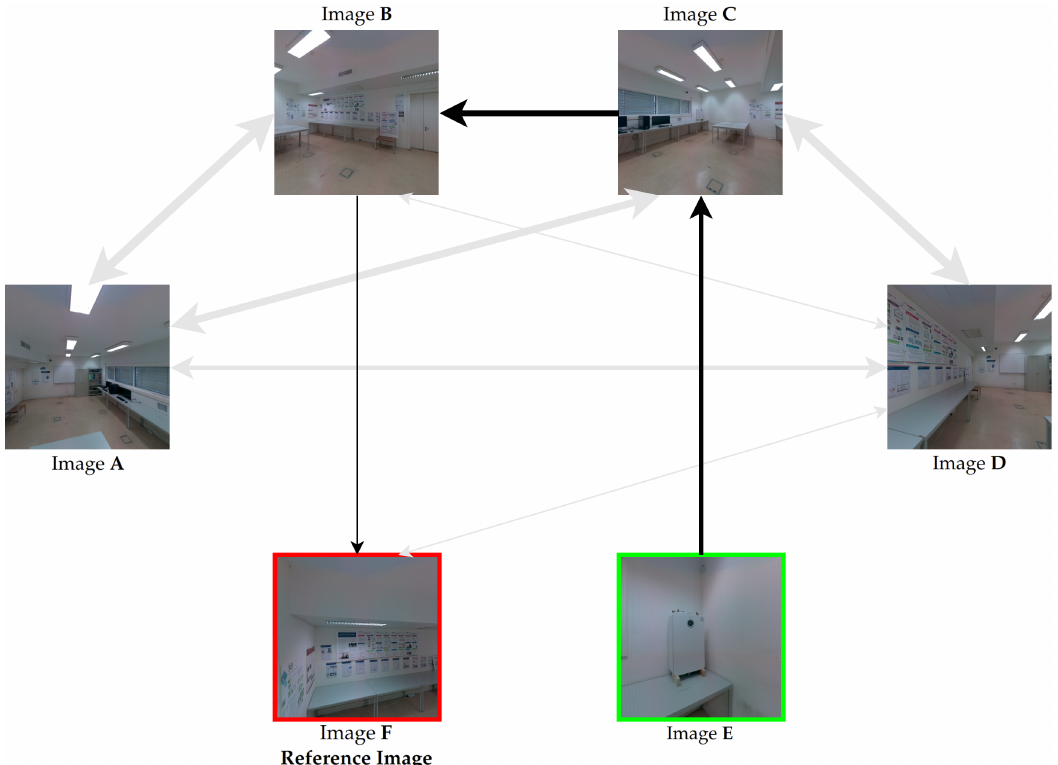
Figure 5. Example of the shortest path from image E to the reference image F , represented by the unidirectional black arrows. The nodes are represented by the individual images, the edges are represented by the arrows, and the thickness of the edges represents their cost. The bidirectional gray arrows are the edges of the graph that were not selected for this